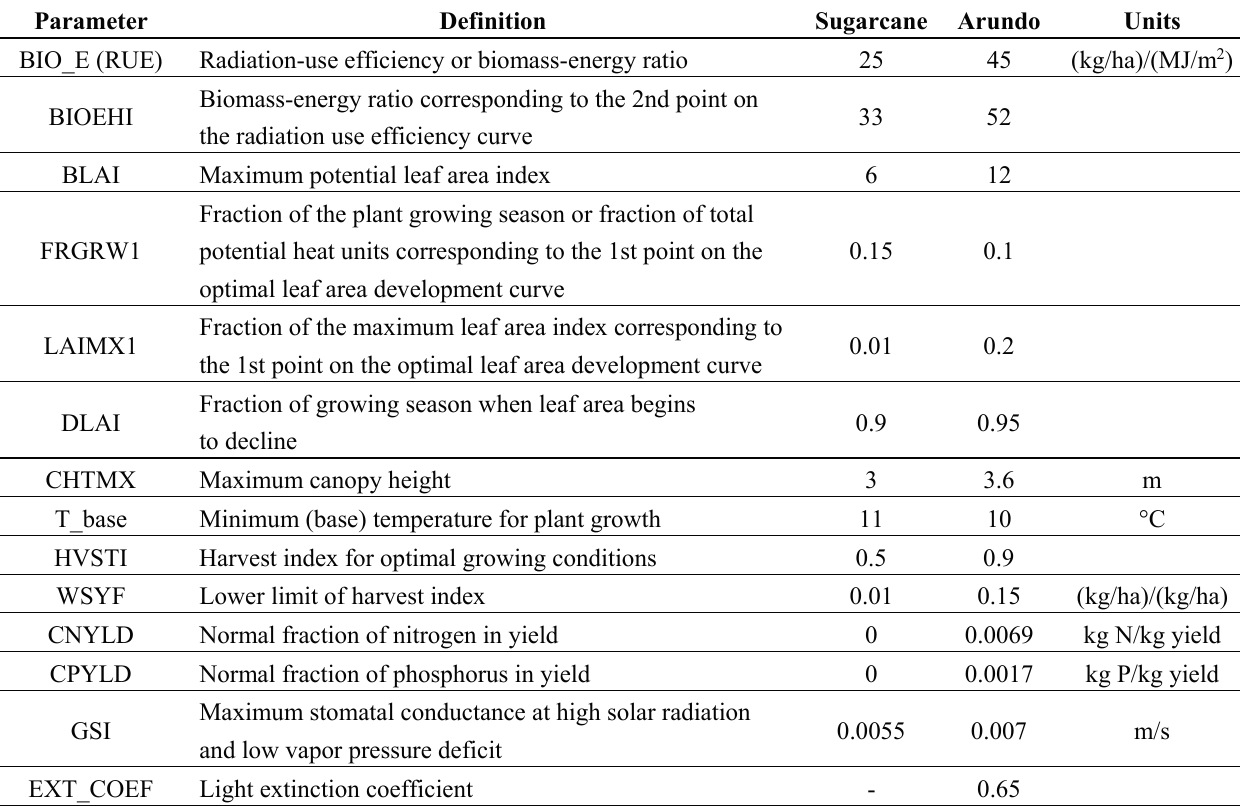
Table 1. Comparison of Arundo parameters determined using Agricultural Land Management Alternatives with Numerical Assessment Criteria (ALMANAC) model with sugarcane parameters (only the parameters that were modified are